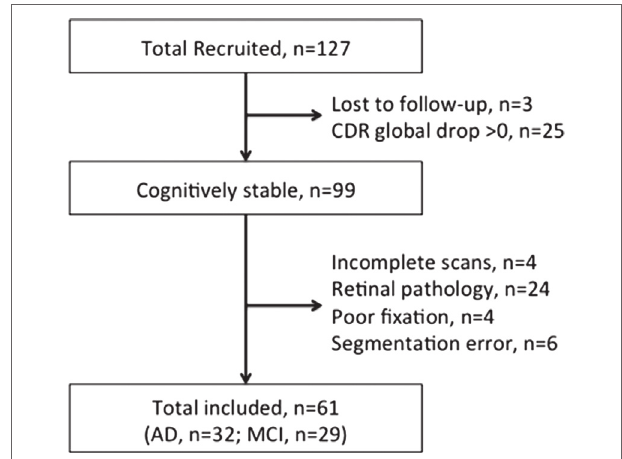
FigUre 1 | Flowchart of Participants for the overall